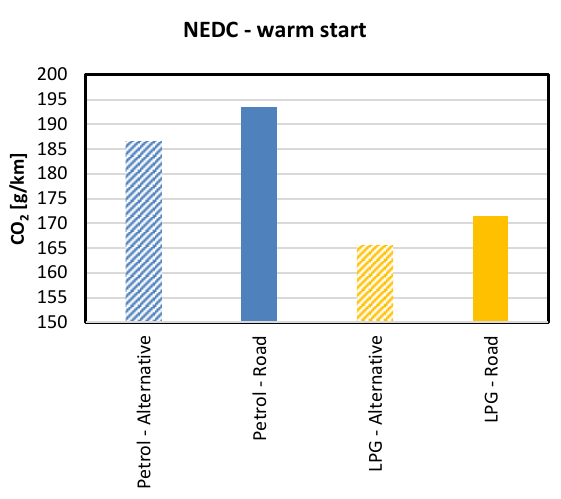
Fig. 6. Impact of resistance forces on CO 2 emissions for NEDC tests